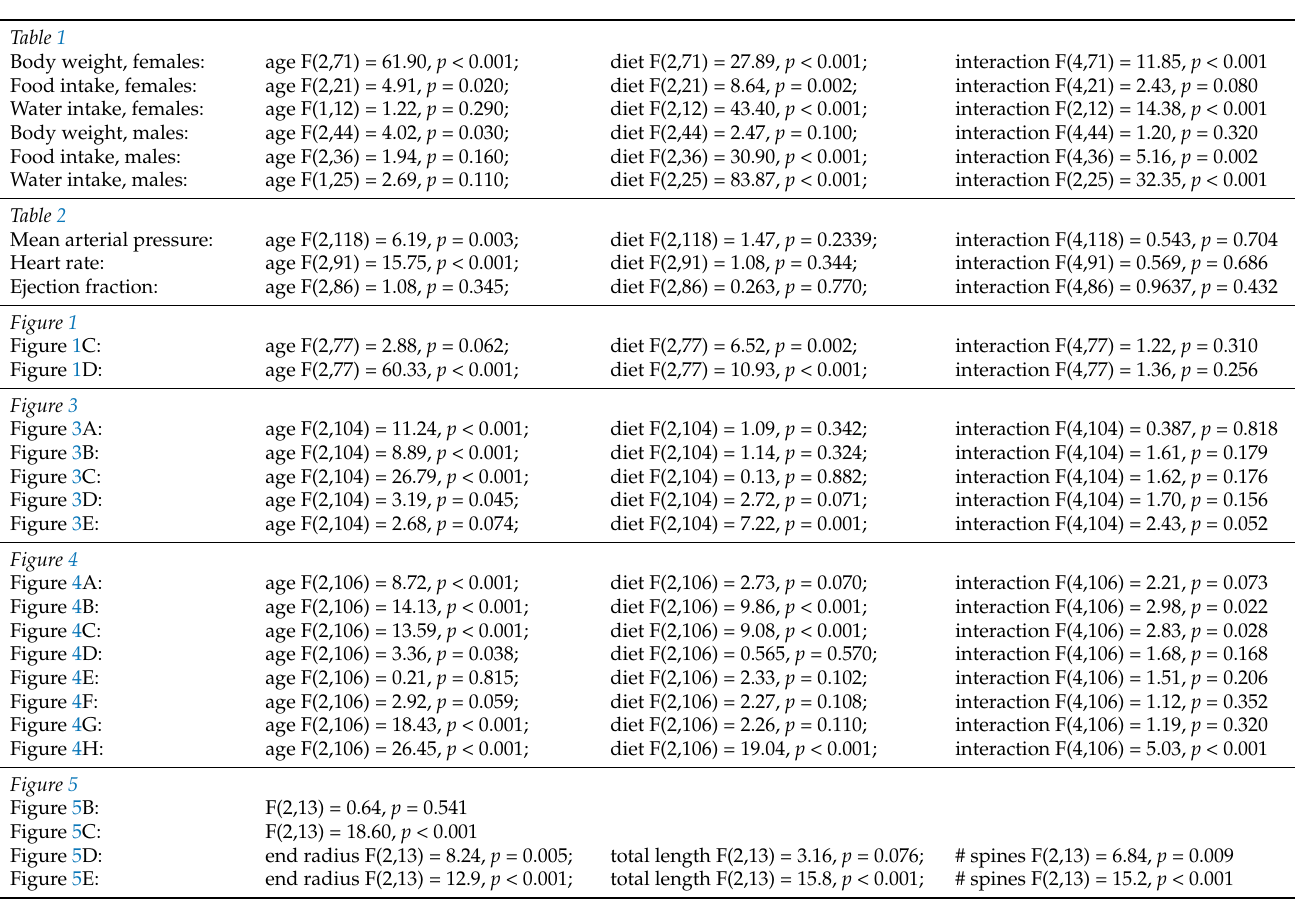
interaction F(4,91) = 0.569, p = 0.686 Ejection fraction: diet F(2,86) = 0.263, p = 0.770; interaction F(4,86) = 0.9637, p = 0.432 interaction F(4,77) = 1.22, p = 0.310 Figure 1D: interaction F(4,77) = 1.36, p = 0.256 interaction F(4,104) = 0.387, p = 0.818 Figure 3B: interaction F(4,104) = 1.61, p = 0.179 Figure 3C: interaction F(4,104) = 1.62, p = 0.176 Figure 3D: interaction F(4,104) = 1.70, p = 0.156 Figure 3E: interaction F(4,104) = 2.43, p = 0.052 interaction F(4,106) = 2.21, p = 0.073 Figure 4B: diet F(2,106) = 9.86, p < 0.001; interaction F(4,106) = 2.98, p = 0.022 Figure 4C: diet F(2,106) = 9.08, p < 0.001; interaction F(4,106) = 2.83, p = 0.028 Figure 4D: diet F(2,106) = 0.565, p = 0.570; interaction F(4,106) = 1.68, p = 0.168 Figure 4E: diet F(2,106) = 2.33, p = 0.102; interaction F(4,106) = 1.51, p = 0.206 Figure 4F: interaction F(4,106) = 1.12, p = 0.352 Figure 4G: interaction F(4,106) = 1.19, p = 0.320 Figure 4H: interaction F(4,106) = 5.03, p < 0.001 F(2,13) = 0.64, p = 0.541 Figure 5C: F(2,13) = 18.60, p < 0.001 Figure